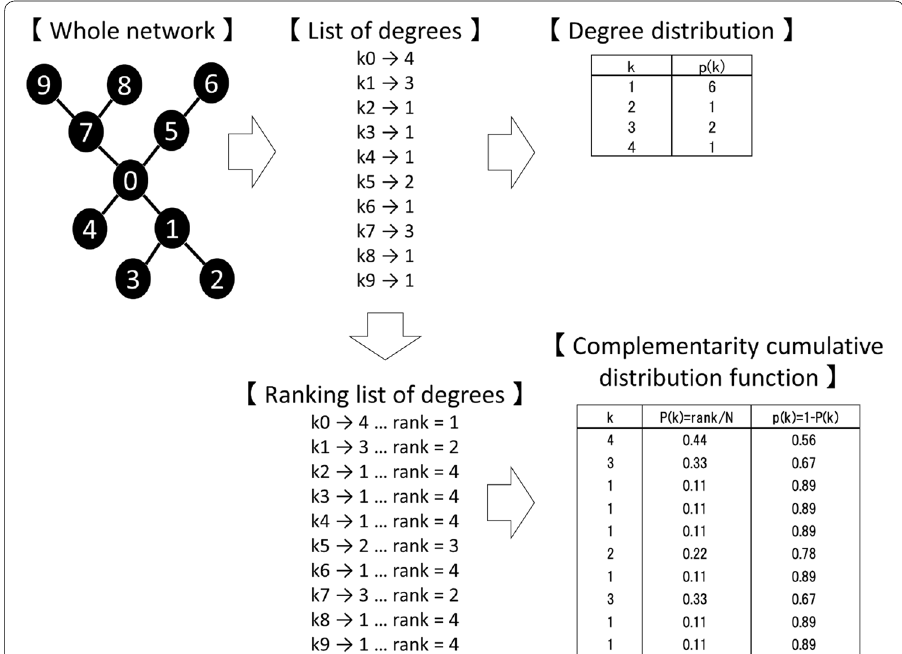
Fig. 3 Conceptual figure of the analysis based on degree distribution and